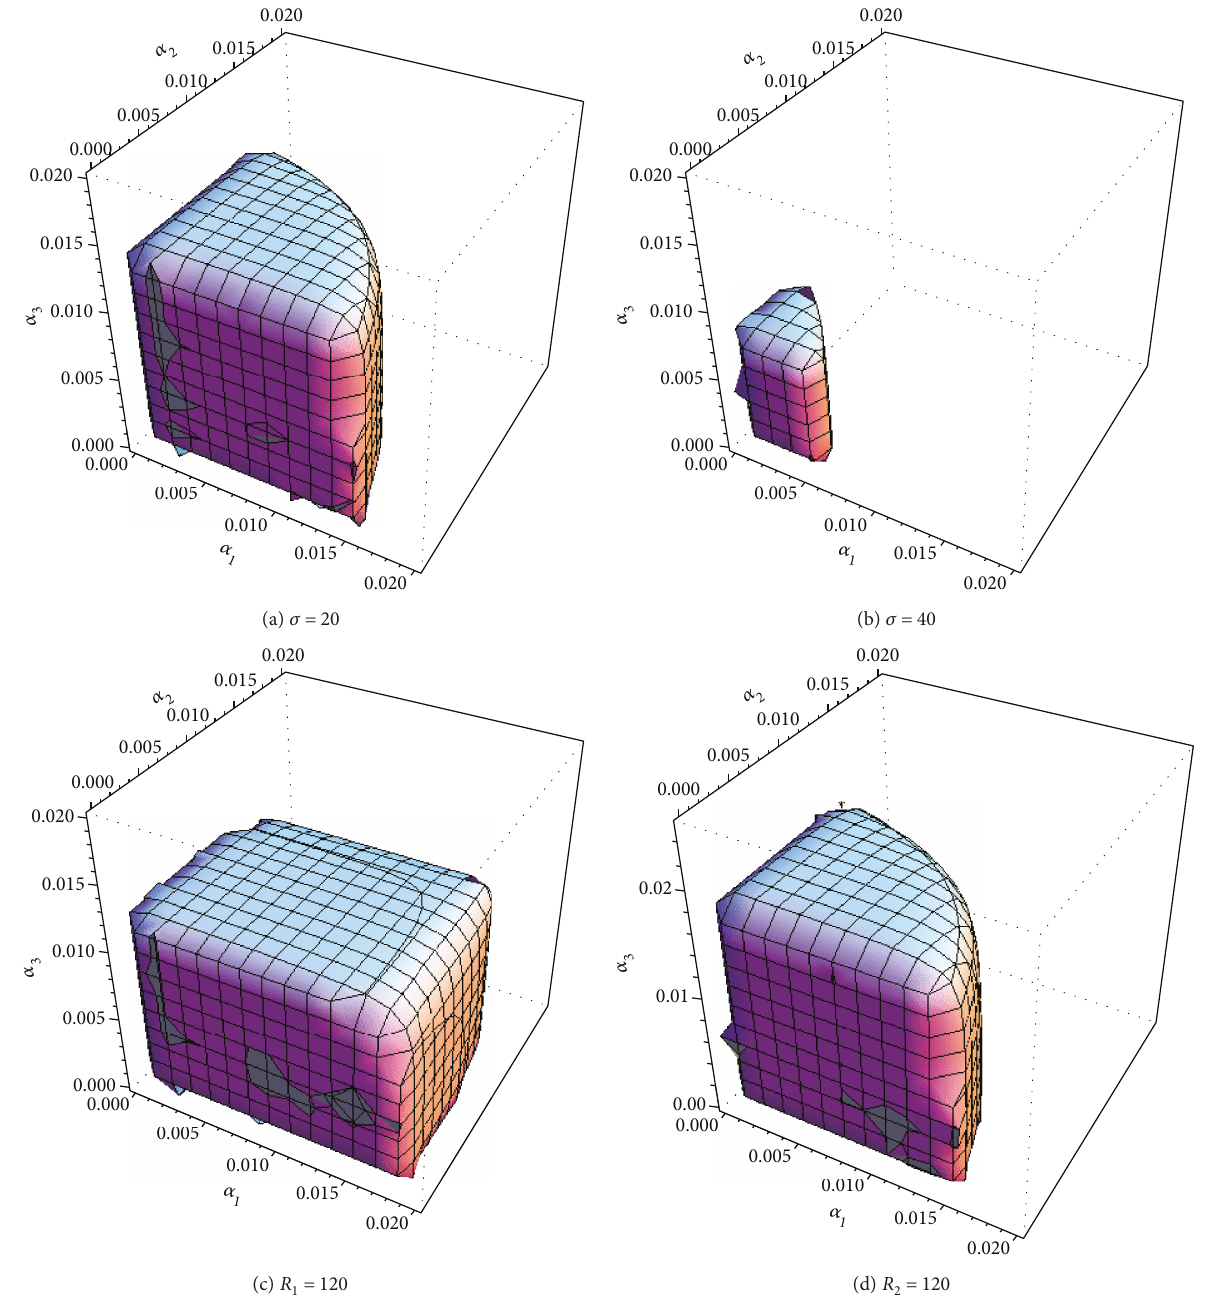
Figure 2: The 3D stable regions of system (12) under di ff erent parameter